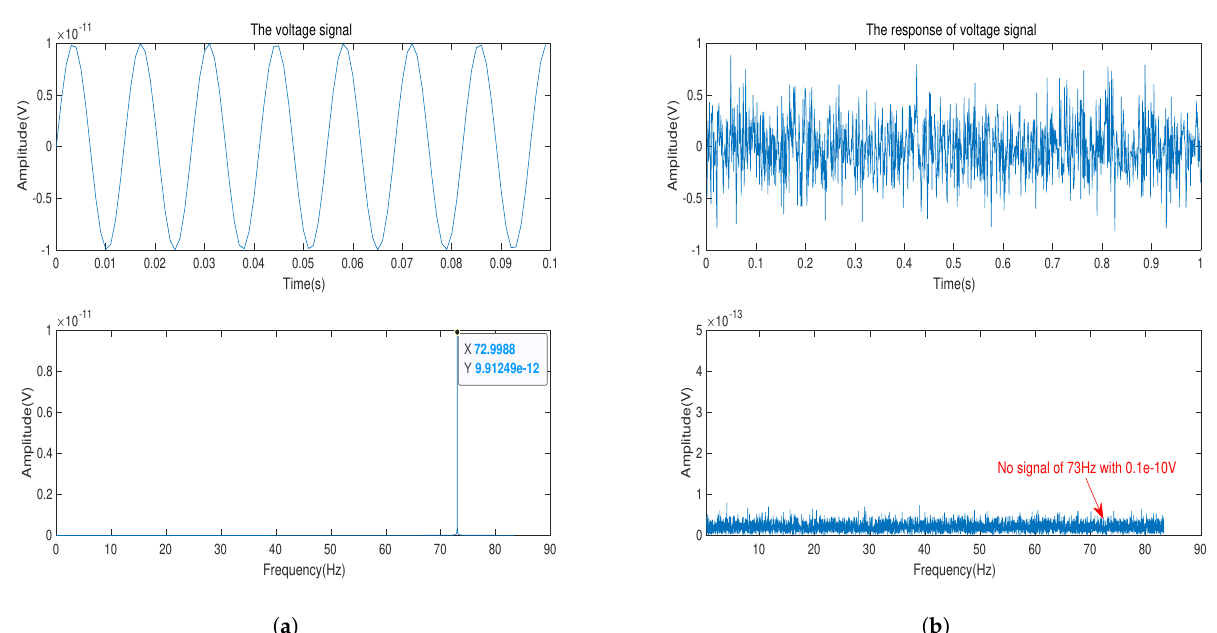
Figure 9. ( a ) The input-voltage signal with amplitude of 0.1 × 10 − 10 V and its frequency spectrum. ( b ) The acquisition voltage signal in time-domain and its frequency spectrum after time gain of 96